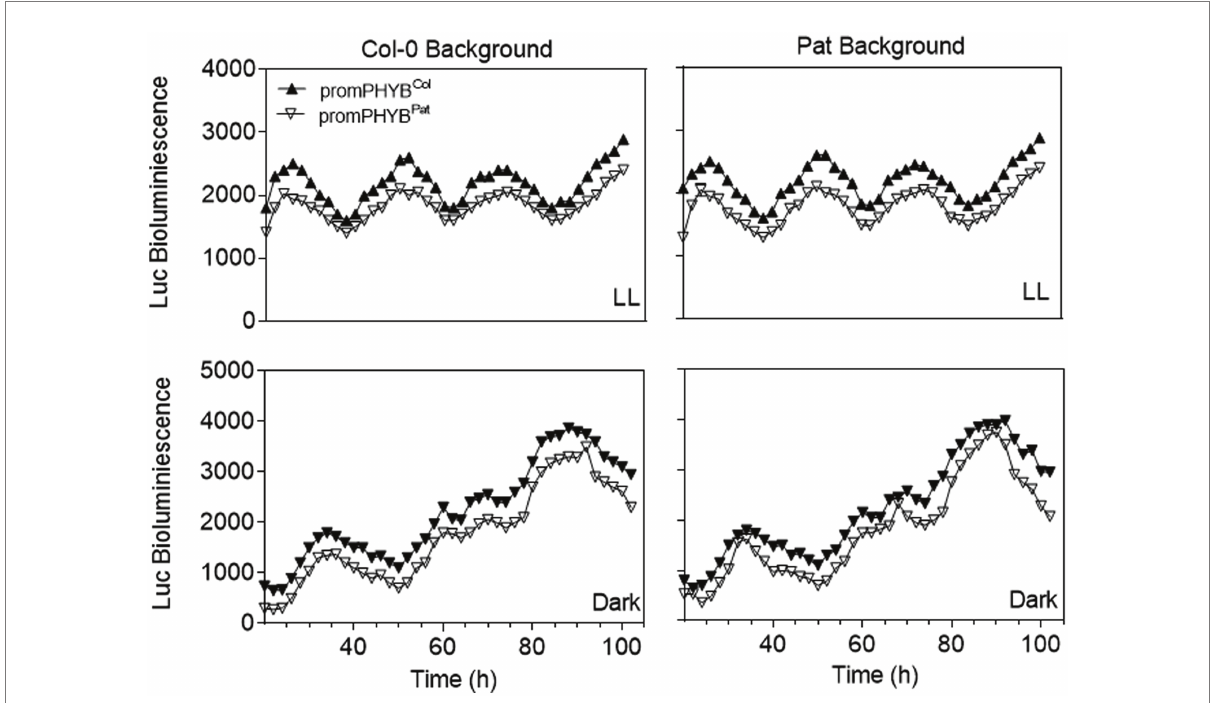
FIGURE 5 Functional analysis of PHYB polymorphisms on the promoter region by LUC analysis. Luc bioluminescence (units) for transgenic plants carrying the promotor of PHYB -Col or PHYB -Pat in the Col and Pat backgrounds. LL continuous light treatment. Each point represents the media of n ≥